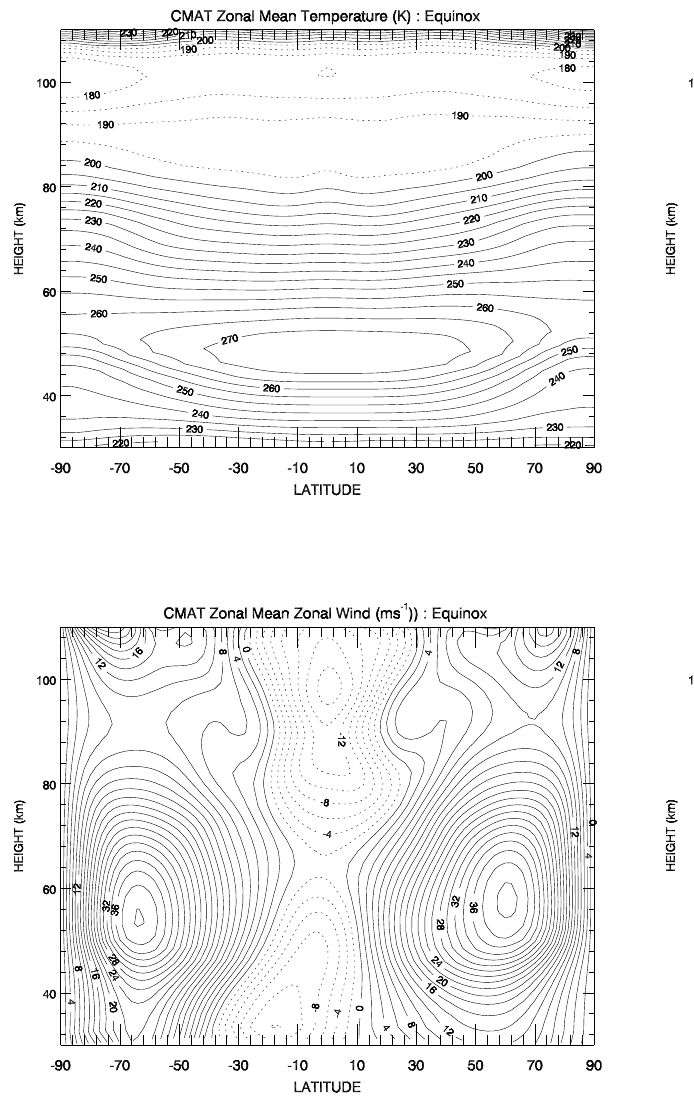
Fig. 1. Zonal mean temperature ( K ) (top) and zonal mean zonal wind (ms − 1 ) (bottom) as calculated by CMAT for equinox. Positive values denote eastward winds.